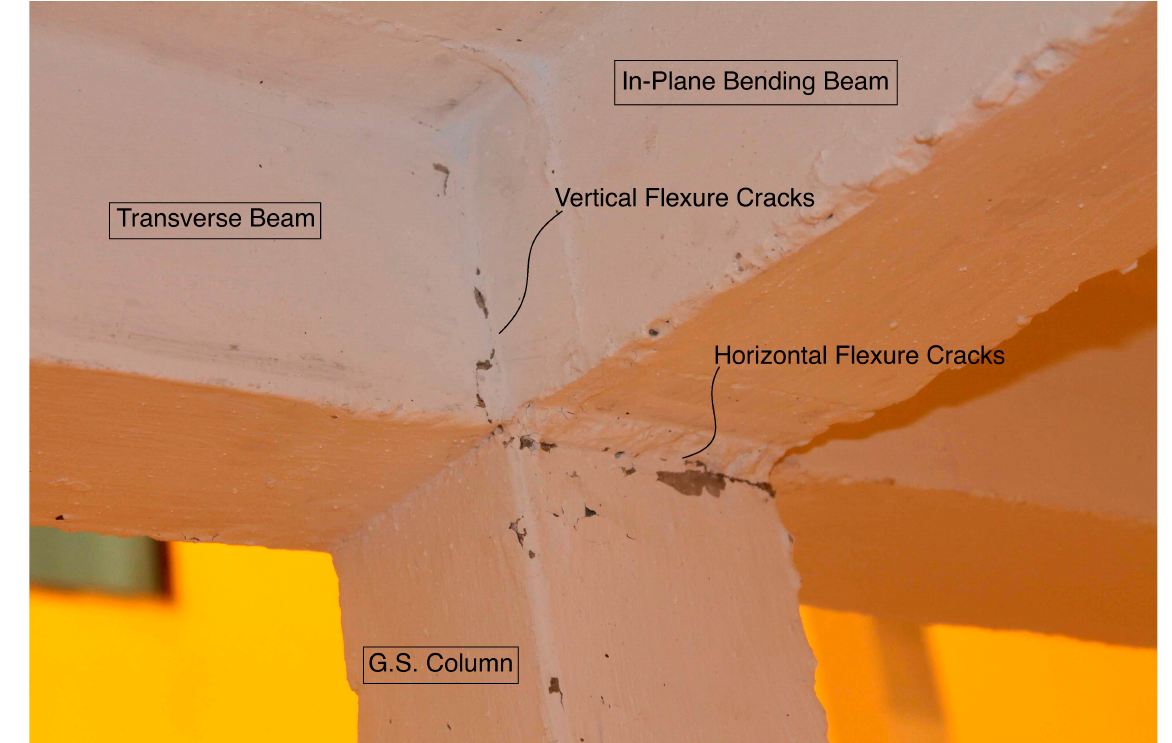
Figure 9. Horizontal and vertical flexural cracks at the beam–joint interface under test run 2 (ref. Table 3). G.S. column refers to the ground story column.